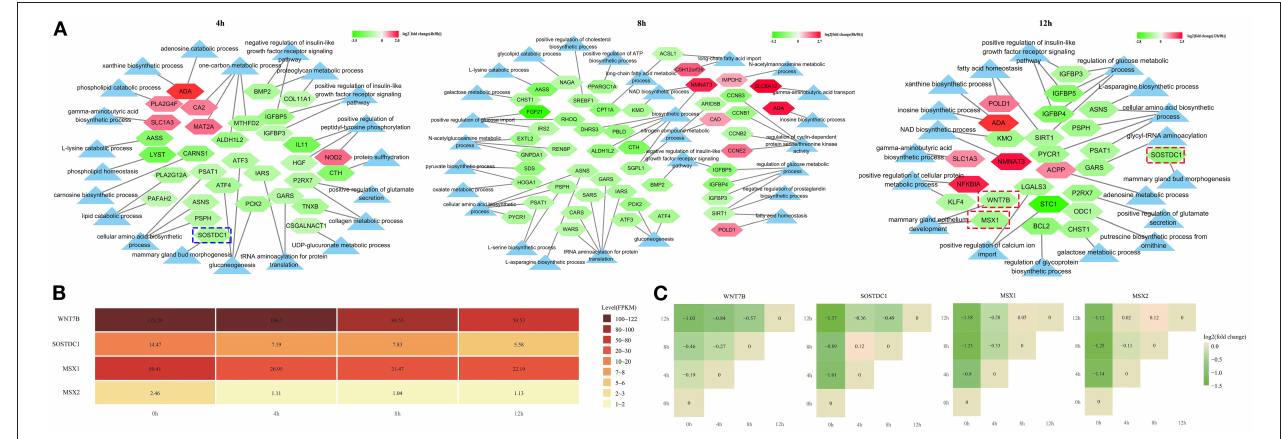
FIGURE 8 | The expression network of the nutrition metabolism pathway-related genes. (A) The light blue triangle represents GO term related to the nutrition metabolism; the pentagon represents the differentially expressed mRNAs related to the nutrition metabolism pathway; (B) The expression level in fragment per kilobase of exon (FPKM), of 4 genes in LPS-induced bMECs; (C) The stair graphic of the relative differential relationship for 4 genes between different timepoints, such as log2(12/0h), log2(8/0h), log2(4/0h), log2(12/8h), log2(12/4h), and log2(8/4h) values. 0, 4, 8, and 12h represent the LPS-induced 0, 4, 8, and 12h bMECs; Green represents downregulation and red represents upregulation in (A,C)